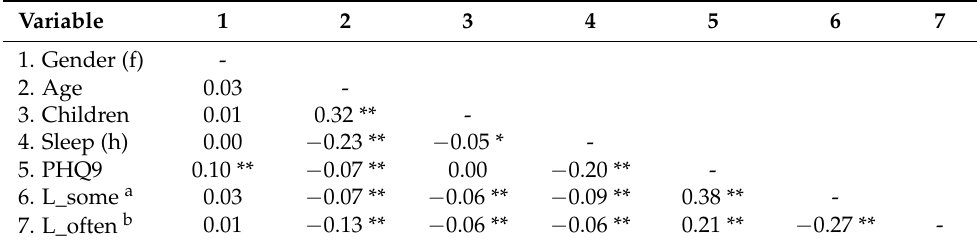
Table 2. Zero order correlation matrix.